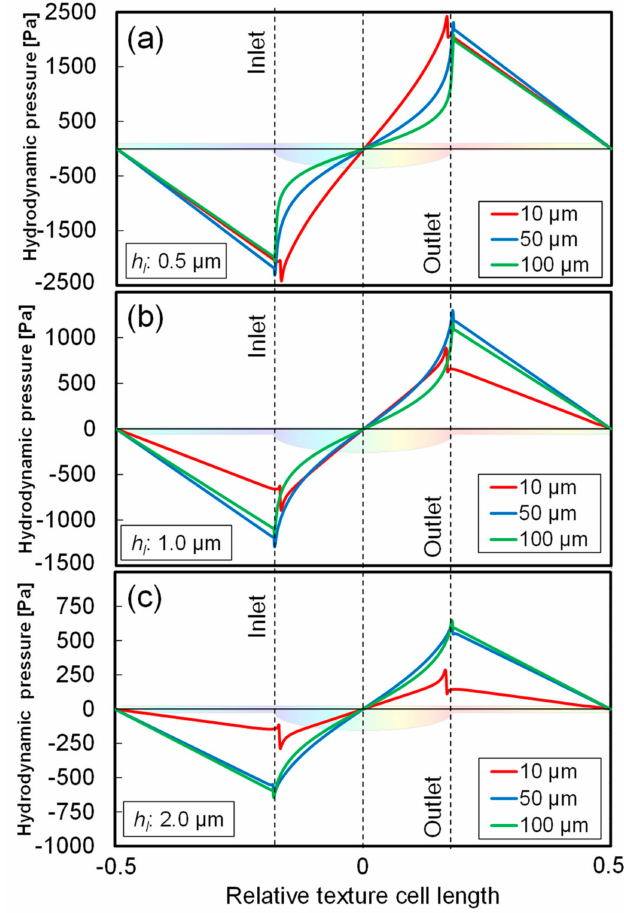
Figure 14. Comparisons of the calculated hydrodynamic pressure distribution between di ff erent dimple diameters of 10 µ m, 50 µ m and 100 µ m under di ff erent lubricant film thicknesses h l of ( a ) 0.5 µ m, ( b ) 1.0 µ m and ( c ) 2.0 µ